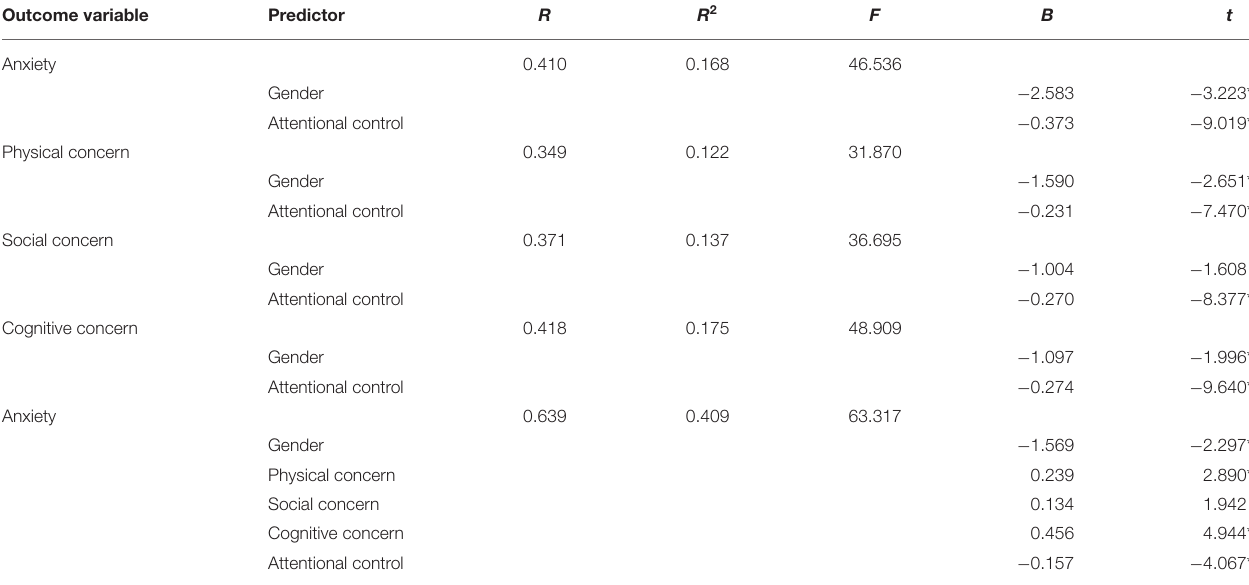
TABLE 5 | Regression analysis of relationships among model variables (physical, social and cognitive concerns as mediating variables). Outcome